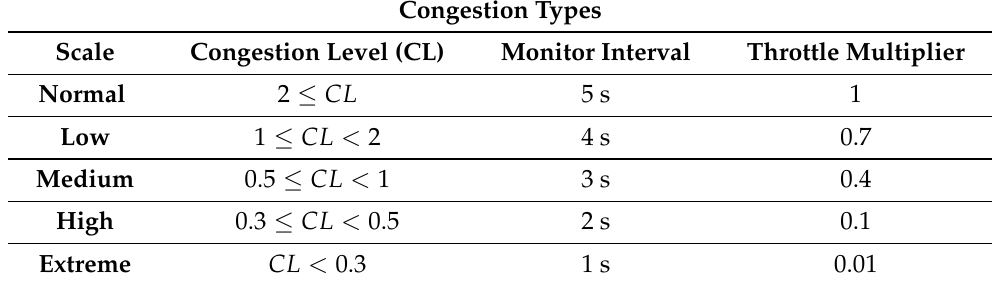
Table 3. Types of